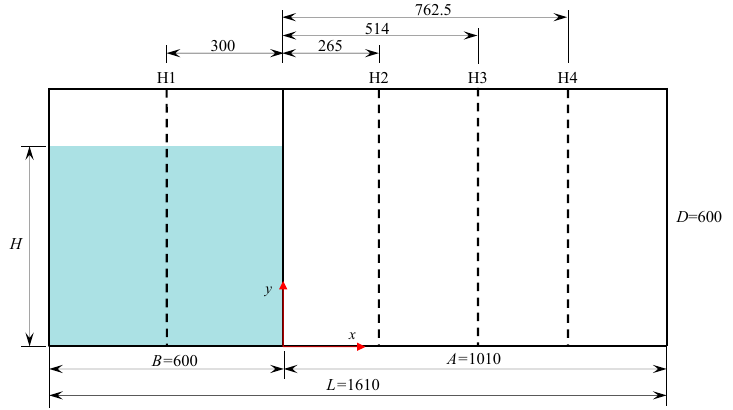
Figure A1. Sketch of experimental setup in the literature of Lobovský et al. (2014).